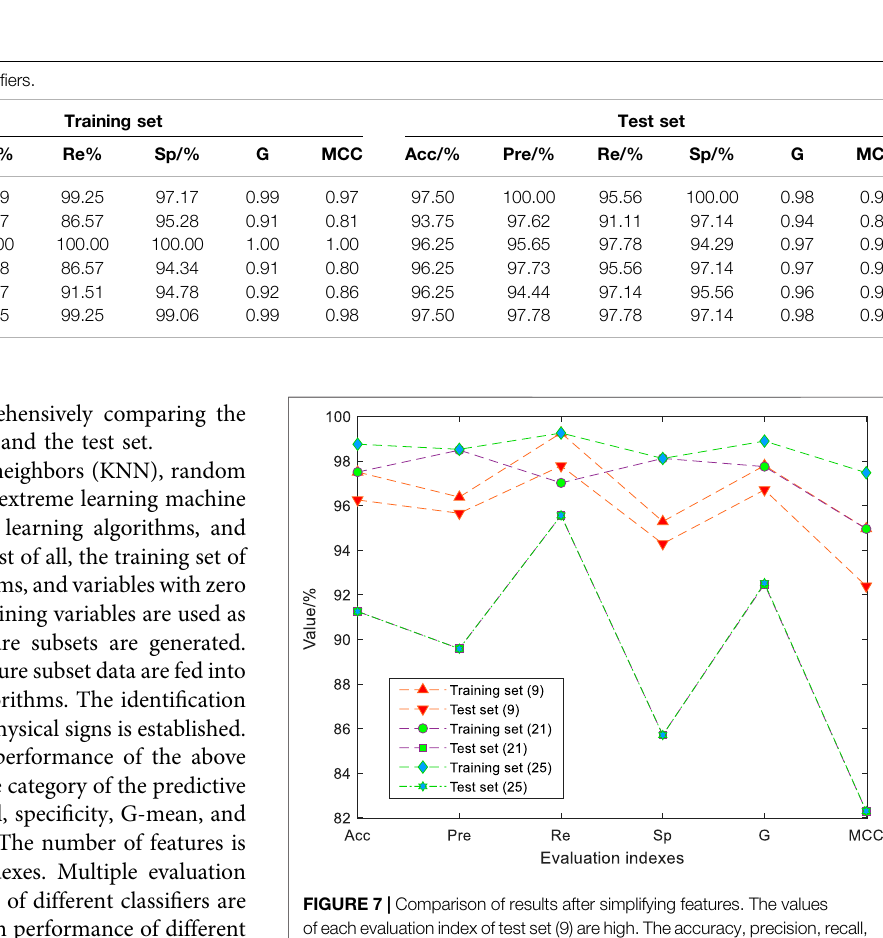
Figure 7 . When the number of physical signs is nine, the GSA-SVC model achieves the best identi fi cation results. The subset of nine features is (DBP, RPP, CHOL, GLU, TG, WGT, SBP, HR, AGE, FEV1%, FEV1/FVC%, and TWA). The accuracy, G-mean, and MCC of the training set of the identi fi cation model